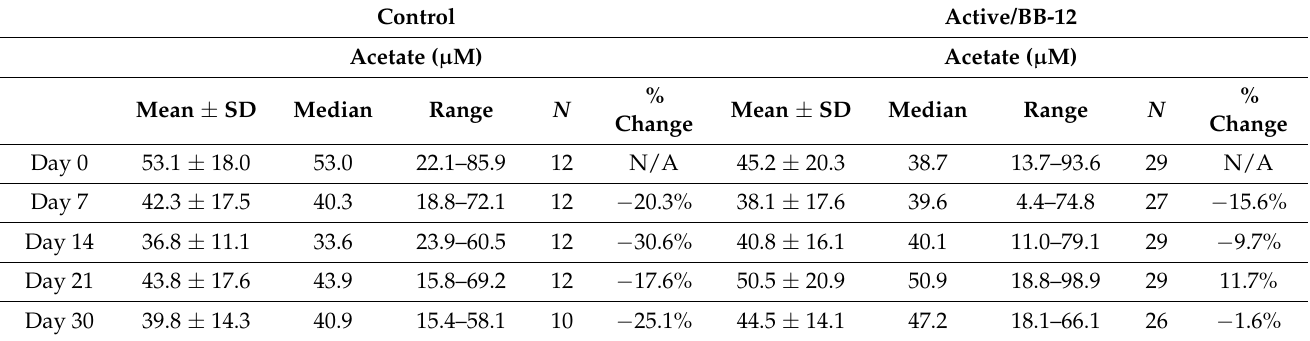
Figure 3. Comparisons of fecal SCFA levels and Shannon diversity at baseline with multiple time points post amoxicillin/clavulanate administration. ( A – C ) % change in average SCFA levels as compared to post run-in (day 0) baseline. ( A ) Acetate, ( B ) propionate, ( C ) butyrate. The acetate control group (red) in ( A ) remains decreased at day 30 ( − 25.1%) whereas active (blue, BB-12) group returns to baseline at day 30 ( − 1.6%). ( D ) Correlation of Shannon diversity between pre- and post-baseline values (Spearman’s rank correlation coefficient R = 0.49, p < 0.05). ( E ) Differences in Shannon diversity between the control (red) and BB-12 (blue) groups at time points pre (baseline 1, day 30), post (baseline 2, day 0), day 7, day 14, day 21, and day 30. Table 2. Fecal SCFA after antibiotics with and without BB-12.